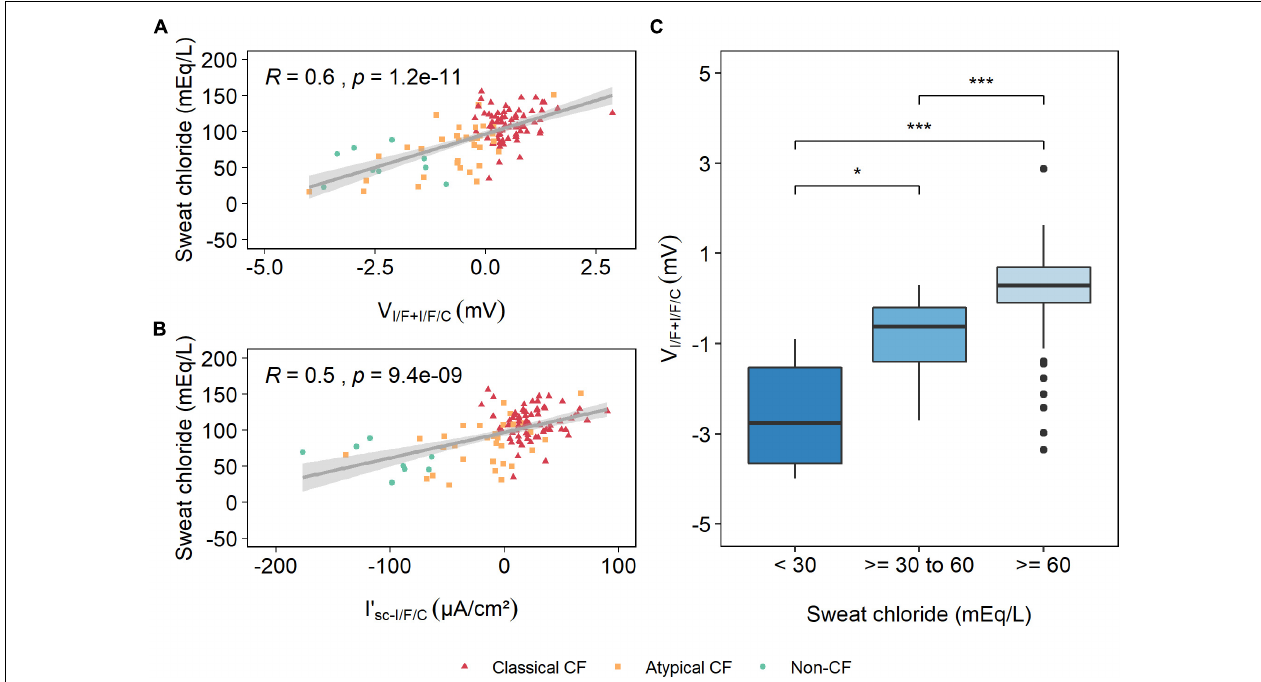
FIGURE 3 | Correlation of sweat chloride (SwCl) concentration with V I / F + I / F / C and I’ sc − I / F / C . A Spearman rho rank correlation analysis showed that there is a strong and positive correlation between SwCl and V I / F + I / F / C with a correlation coefficient of ∼ 0.6 (A) , whereas I’ sc − I / F / C evidenced a moderate correlation with a coefficient of ∼ 0.5 (B) . R represents the correlation coefficient and p is the p -value. (C) V I / F + I / F / C values were plotted against SwCl values for each group of individuals with distinct levels of disease severity, showing that individuals with higher V I / F + I / F / C values are associated with higher SwCl values, whereas individuals with lower V I / F + I / F / C values are associated with lower SwCl values. Significant differences were found between these three groups by a Kruskal–Wallis rank sum test. (* p ≤ 0.05; ** p ≤ 0.01). After Bonferroni correction only the 30–60 mmol/L and ≥ 60 mmol/L groups were significantly different (* p < 0.05; ** p ≤ 0.01).